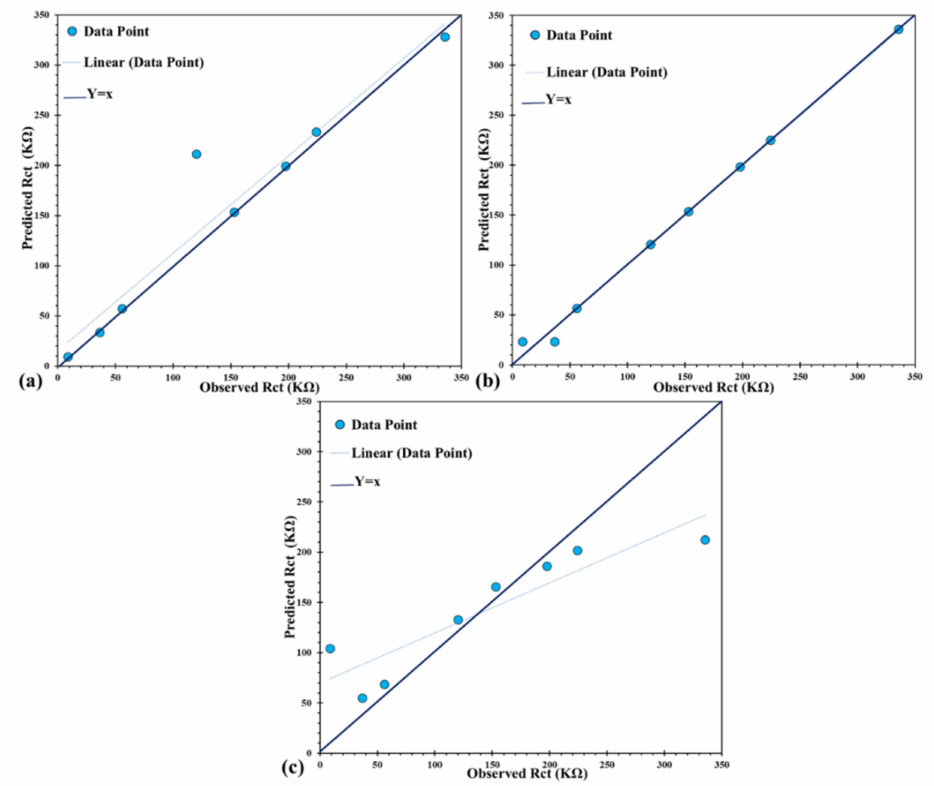
Figure 11. The correlation of the observed and predicted Rct of CeCCs obtained by the computational models: ( a ) ANN, ( b ) ANFIS, and ( c ) SVMR. The dashed line shows a fitted line to the modeling result, and solid lines represent the line with a slope of